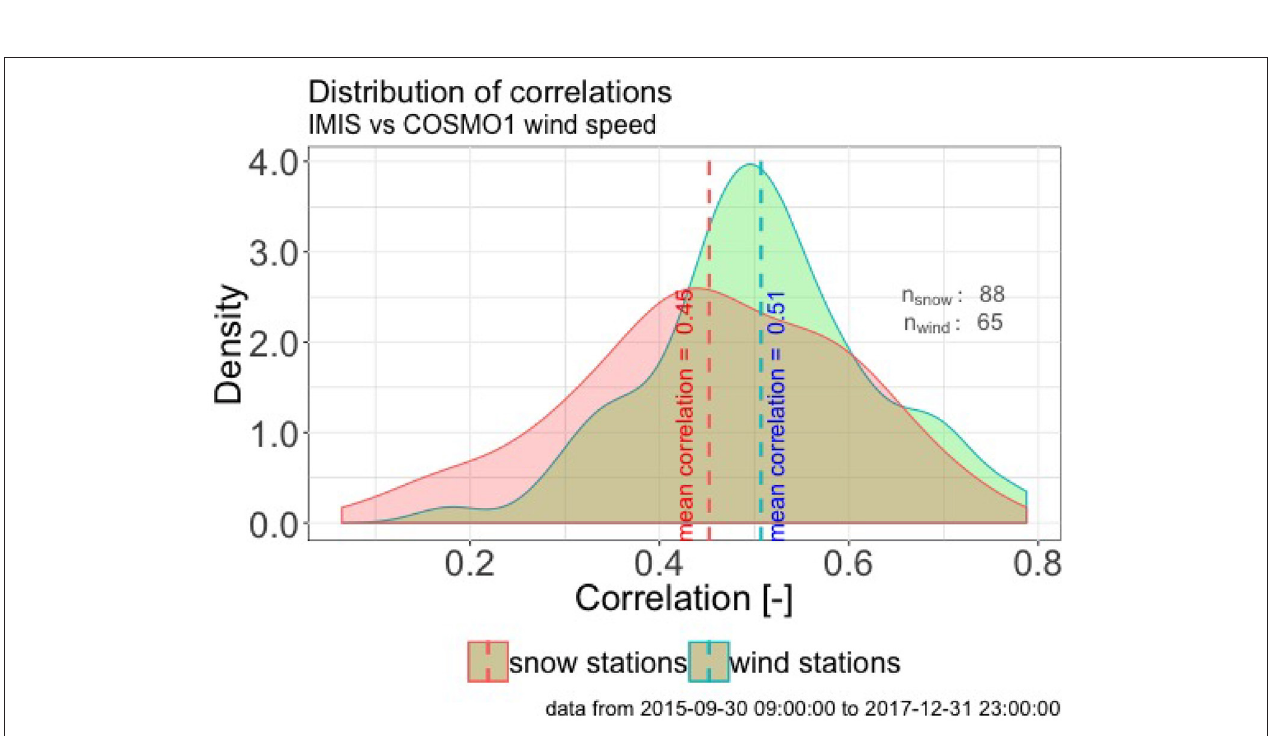
FIGURE 5 | Correlations between IMIS and COSMO-1 wind speeds, for both wind- and snow stations. Correlation coefficients were calculated between the wind speed timeseries of each station and the wind speed timeseries of the corresponding COSMO-1 grid cell.